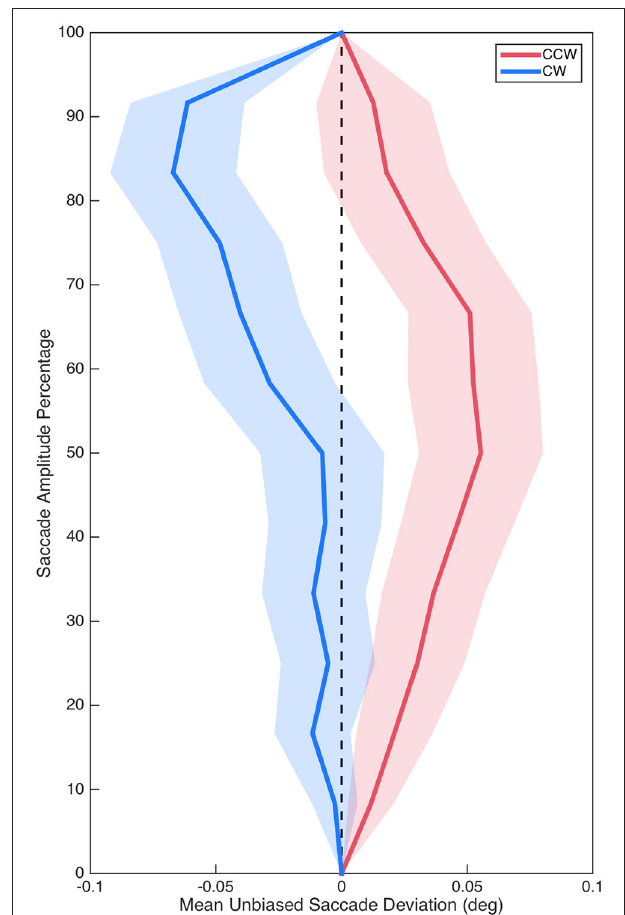
FIGURE 3 | Mean unbiased saccade trajectories for saccades in the CCW (red) and CW (blue) conditions. Shading represents standard error.